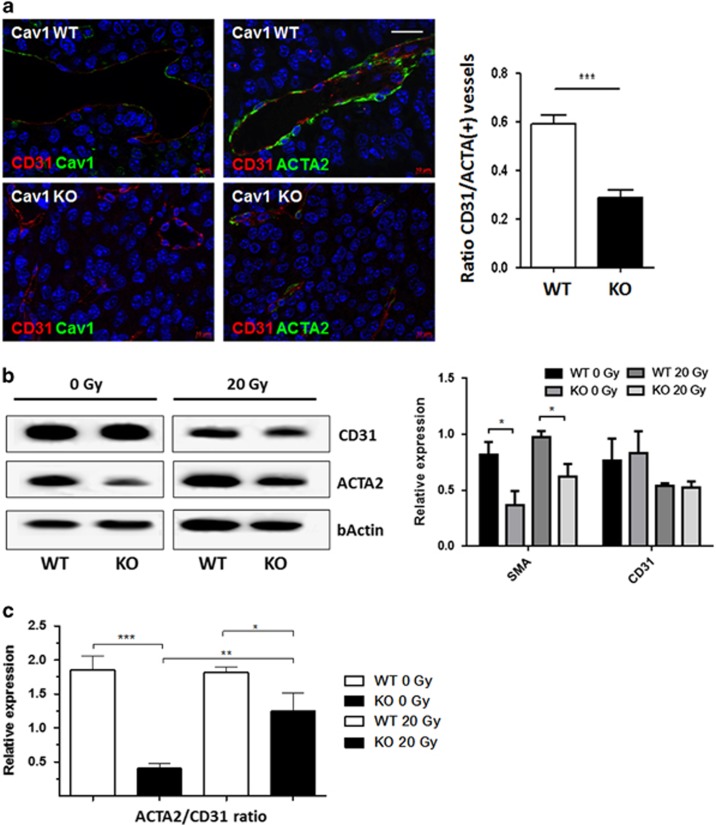
Prostate tumors grown in Cav1-deficient mice showed a less stabilized vascular phenotype. (a) Subcutaneously grown MPR31-4 tumors were analyzed by immunofluorescence and confocal microscopy. Left panel: vessels were stained for CD31 (ECs, red) and Cav1 (green) or smooth muscle actin (ACTA2; pericytes/smooth muscle cell, green). Scale bar. 50 μm. Right panel: CD31- and ACTA2-positive blood vessels were quantified by counting immunoreactive structures in whole-tissue sections and the ACTA2/CD31 ratio was calculated (n=5). (b) CD31 and ACTA2 expression levels were determined using western blot analysis. (c) Protein levels were analyzed by densitometry and normalized to β-actin (bActin) levels (relative protein expression). Data are presented as means±s.d. from three independent experiments with multiple samples (n=5 per group).